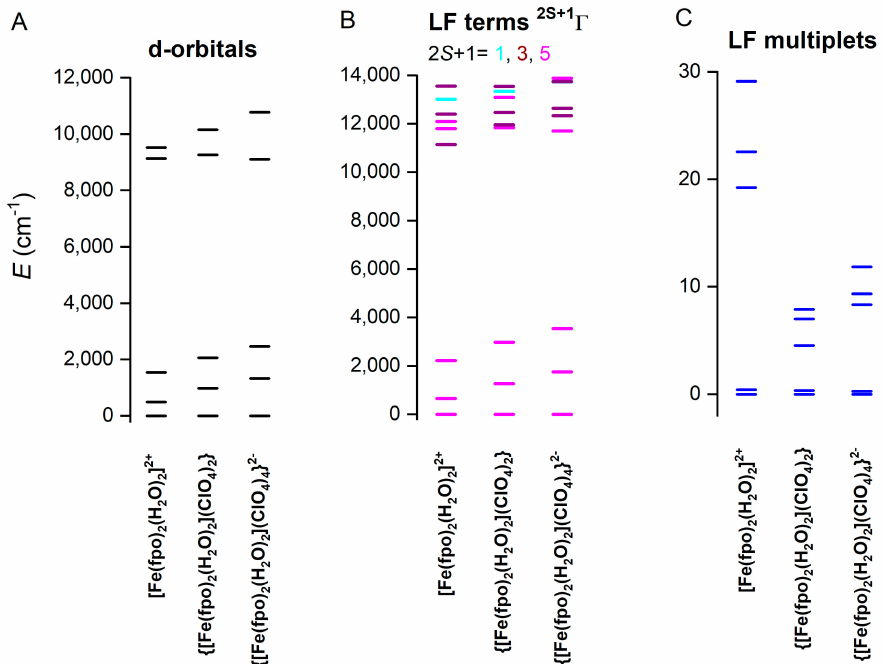
Figure 7. The graphical output of the CASSCF / NEVPT2 calculations with CAS(6,5) for the mononuclear molecular fragments of 1. Plot of the d-orbitals splitting calculated by the ab initio ligand field theory (AILFT) ( A ), low-lying ligand-field terms ( B ), and ligand-field multiplets—Kramers doublets ( C ). The quintet, triplet, and singlet spin states are shown in distinct colours.